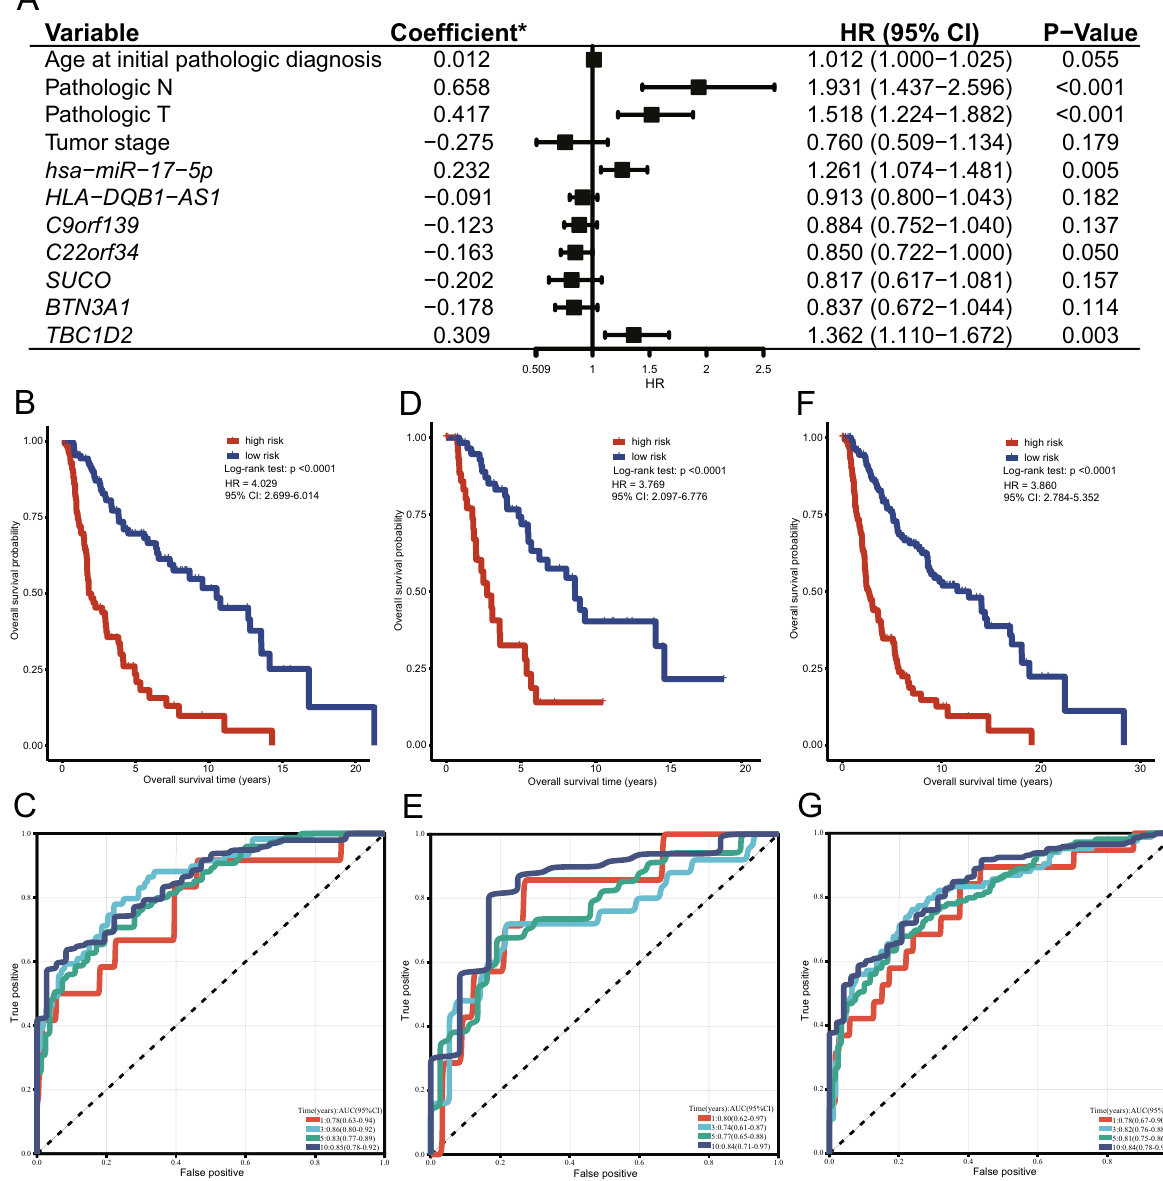
Figure 4. A CM prognosis model integrating CM prognosis related immune molecules and clinical variables. Forest plot of multivariate Cox regression for the integrated prognosis model ( A) . Kaplan–Meier survival analyses for the integrated prognosis model based on the overall survival of the training set ( B) , the testing set ( D), and the entire set ( F) , respectively. ROC analyses for the integrated prognosis model based on the overall survival of the training set ( C) , the testing set ( E), and the entire set ( G) , respectively. Asterisk: multivariate Cox regression coefficient. HR hazard ratio, 95% CI 95% confidence